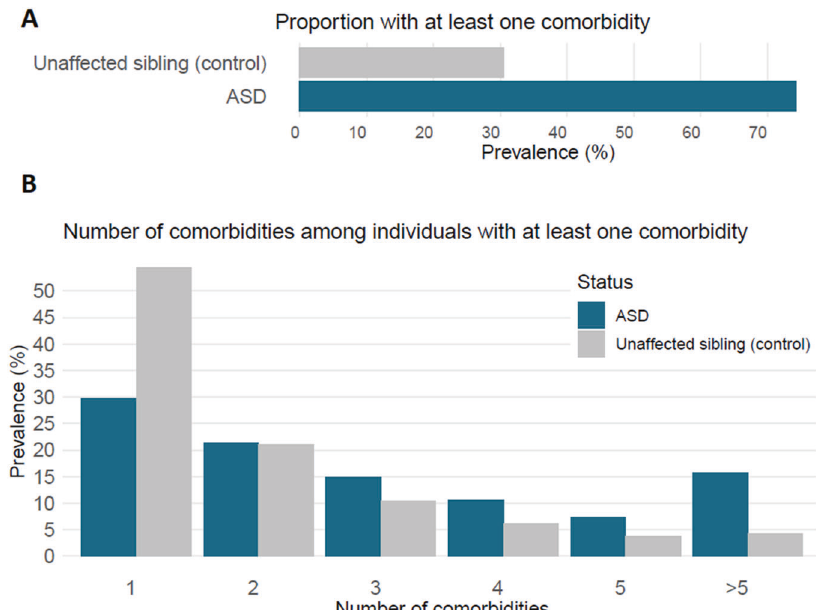
Fig. 3 Burden of comorbid conditions in ASD cases and their unaffected siblings. A Prevalence of individuals with >1 comorbidity by ASD status. B Distribution of the number of comorbidities among those with at least one comorbidity by ASD